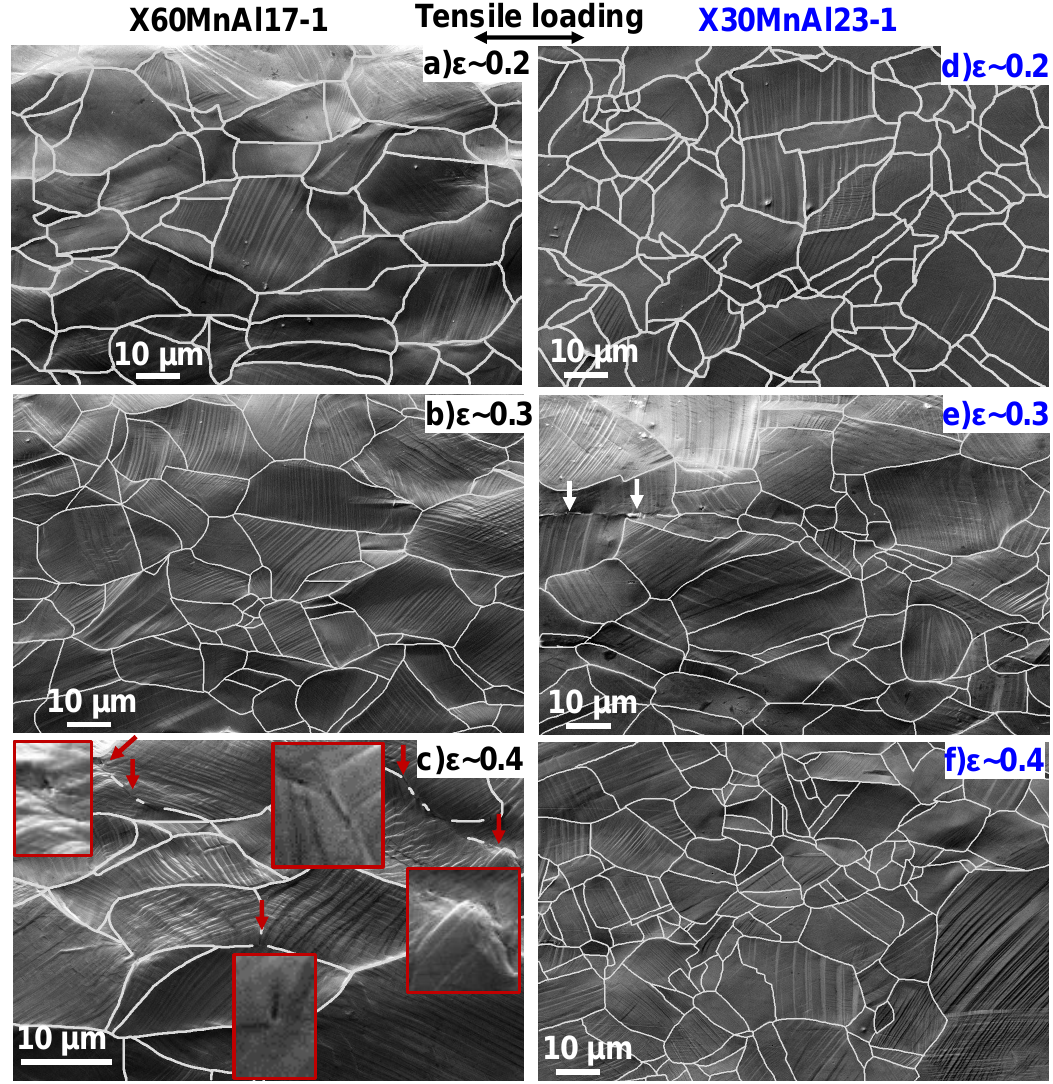
Figure 9. Evolution of microstructure and micro-crack formation with deformation. X60MnAl17-1: ( a ) ε ∼ 0.2 ( b ) ε ∼ 0.3 ( c ) ε ∼ 0.4 (left column), X30MnAl23-1: ( d ) ε ∼ 0.2 ( e ) ε ∼ 0.3 ( f ) ε ∼ 0.4 (right column); red arrows indicate micro-cracks; white arrows indicate cracks in MnS inclusions at grain boundary (GB); macroscopic true strain is indicated at the top right